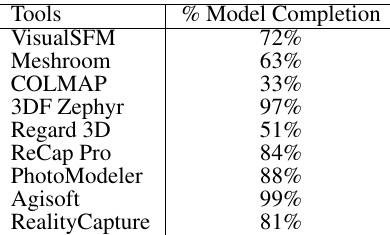
Table 5. Percentage rebar model